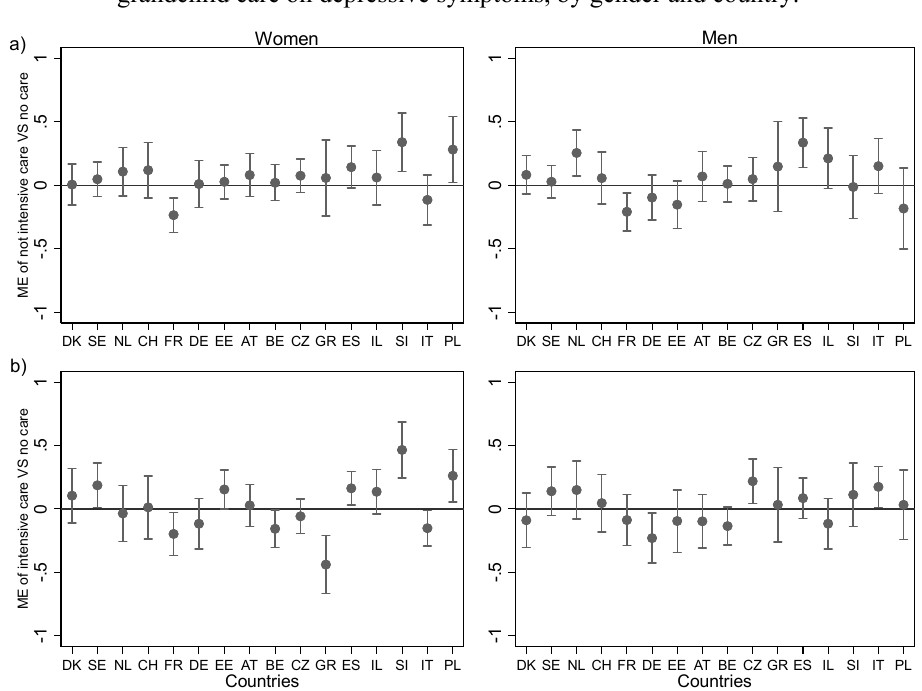
Figure 2 : Marginal effects (ME) from fixed-effects models for the effect of a) providing not intensive or b) intensive grandchild care compared to not providing grandchild care on depressive symptoms, by gender and